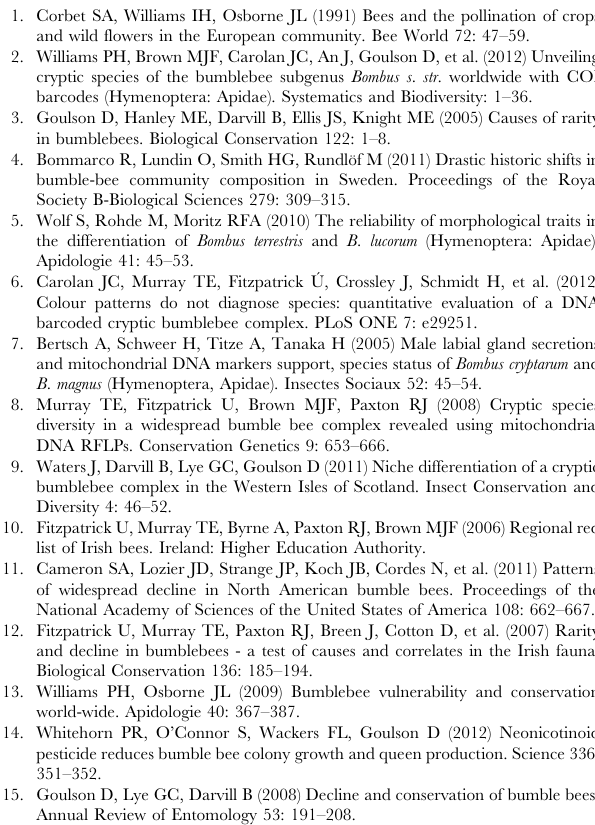
Table S3 Colony density estimations for a) Bombus terrestris , b) B. lucorum , c) B. cryptarum and d) B. lapidarius at each site. N ind = number of individual worker bees sampled, N sis = total number of sister pairs found within the sampled individuals using COLONY analyses of microsatellite data, and in the oilseed rape field only (OS), adjacent field only (ADJ) and shared between the two (Shared). N obs =number of colonies observed, based on sibship reconstruction from Colony. N tot = total number of colonies estimated, including un-sampled ones, using TIRM or ECM methods in CAPWIRE. ECM methods are equivalent to previously used truncated Poisson methods [25]. A likelihood ratio test (LRT) was also used to compare between models for each sample, and best model is shown here; this was not used in the main text as it is sensitive to small sample sizes [47], but is given here for comparison with previous work. Values with no upper limit, or where estimates were not possible due to an absence of sister pairs (or no re- captures), are marked ‘‘n/a’’. CAPWIRE models were run in 0.1 95% confidence intervals for the estimate on population size based on 1000 bootstrap replicates; a largest population size of 750 for dimensioning; and a likelihood ratio rejection region of 0.2 when conducting likelihood ratio tests. N km = number of colonies estimated per km 2 based on ECM estimations and foraging distances from Knight et al. [33]. Table S4 Final generalized linear models describing the effects of landscape composition variables on propor- tions and colony density estimates of each species, simplified from a full model which included: area of